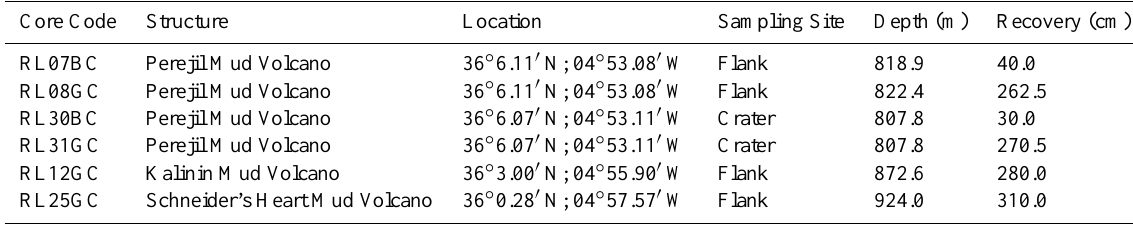
Table 1. General sampling information on the studied sites: location, water depth and length of the studied cores. Core